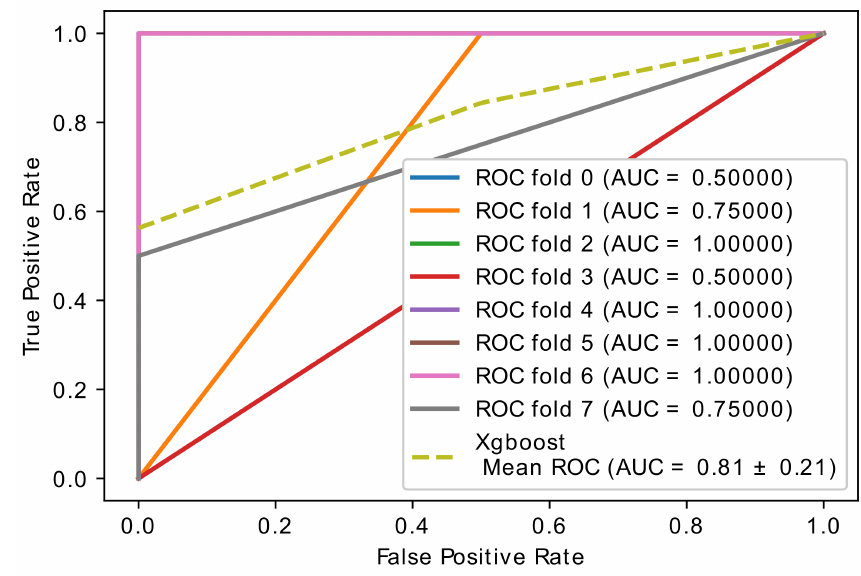
Figure 4. Accuracy curve obtained using the hybrid model with optimized CatBoost classifier.